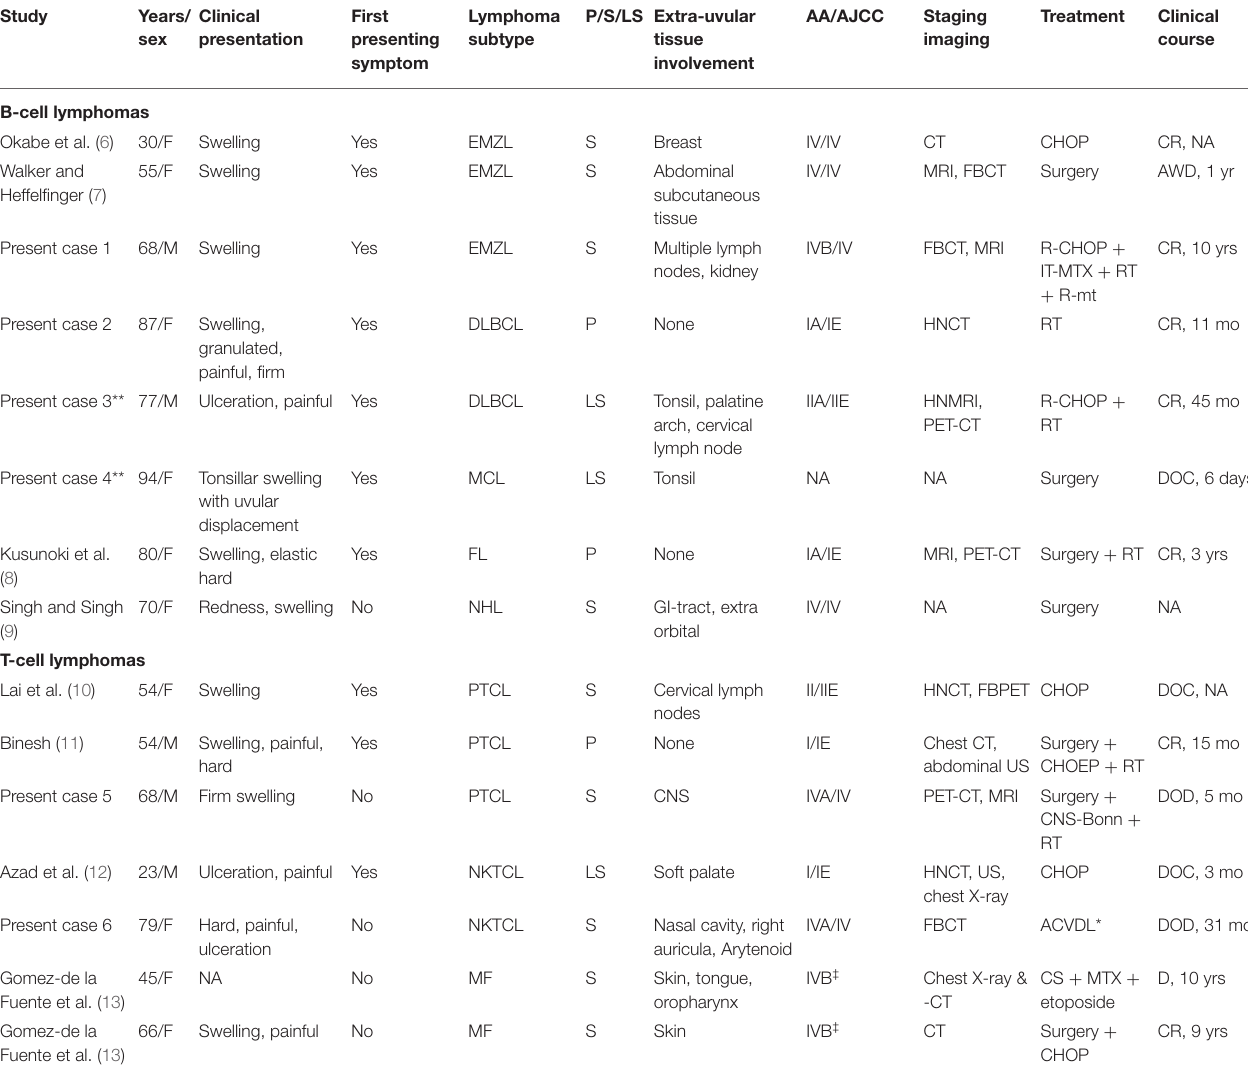
TABLE 1 | Demographic, clinical presentation, subtype, possible dissemination, stage, imaging, treatment and outcome of all previously published, and present uvular Lymphomas.